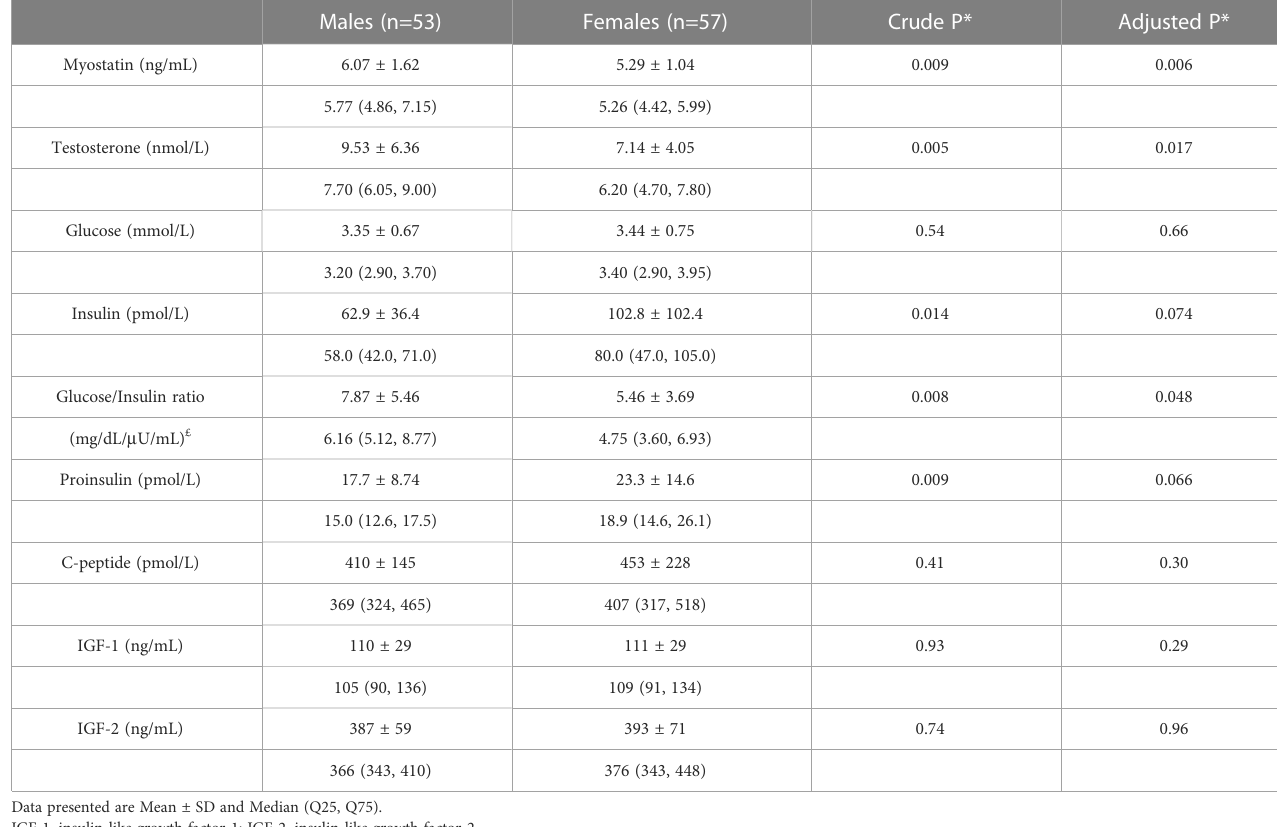
TABLE 3 Cord blood concentrations of myostatin, testosterone and fetal growth factors comparing male vs . female newborns. Males (n=53)